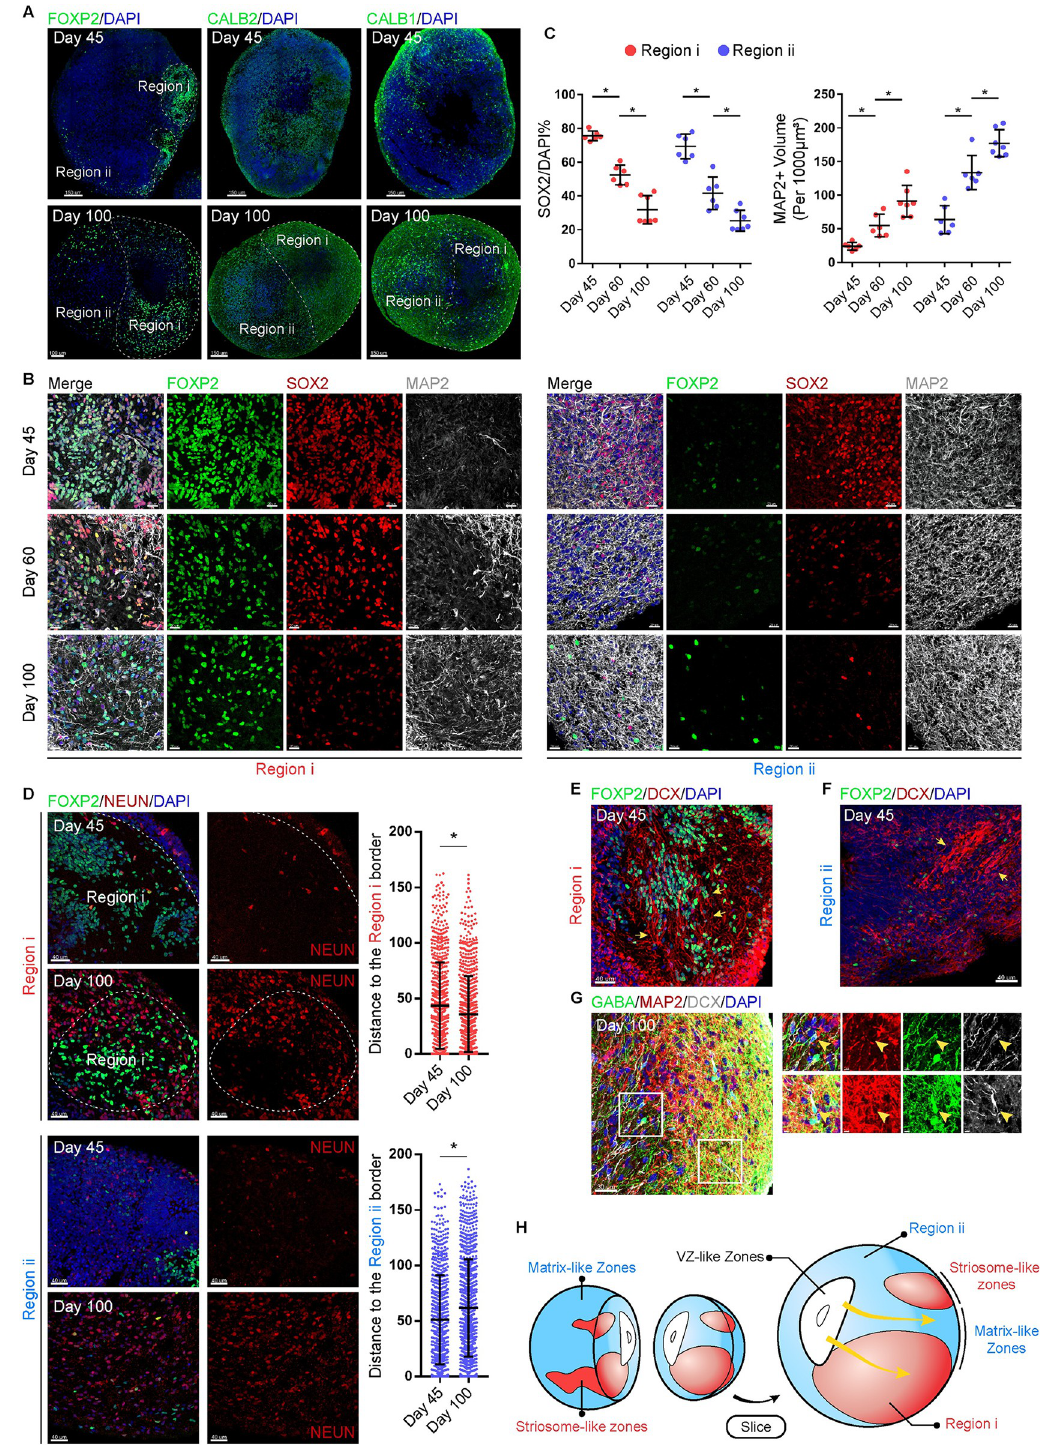
Fig 4. Dynamic regionalization in developing hStrO. (A) Immunostainings for CALB1, CALB2, and FOXP2 antibodies in Day 45 and Day 100 hStrOs. Scale bar, 150 μ m. (B, C) Immunostainings for SOX2, MAP2, and FOXP2 in Day 45, Day 60, and Day 100 hStrOs. Images were collected from Regions i and ii, respectively. Quantifying the proportion of SOX2+ cells and the volume of MAP2+ dendrites in the supposed regions. Organoids, n = 6–7. Two-way ANOVA. � , P < 0.05. Scale bar, 20 μ m. (D) Immunostainings for NEUN and FOXP2 antibodies in Day 45 and Day 100 hStrOs. Scale bar, 40 μ m. Quantification of